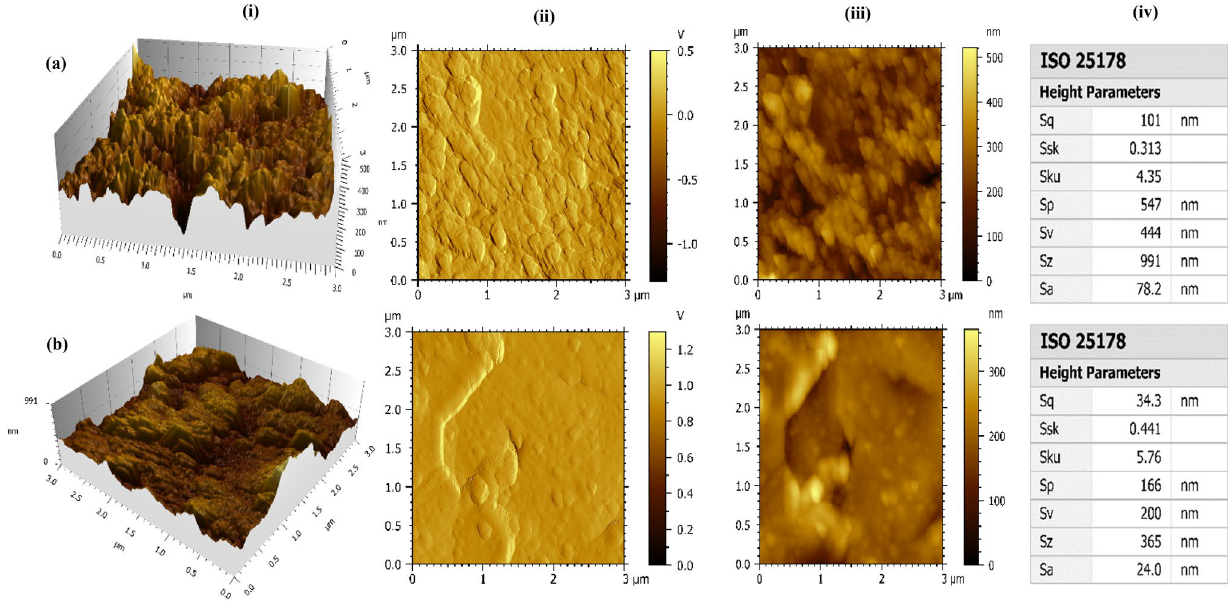
Fig. 11 AFM images of (i) 3D morphology (ii) amplitude (iii) topographyand (iv) height parameters for X80 steel surface after immersion in a 1 M HCl and b 1 M HCl inhibited by